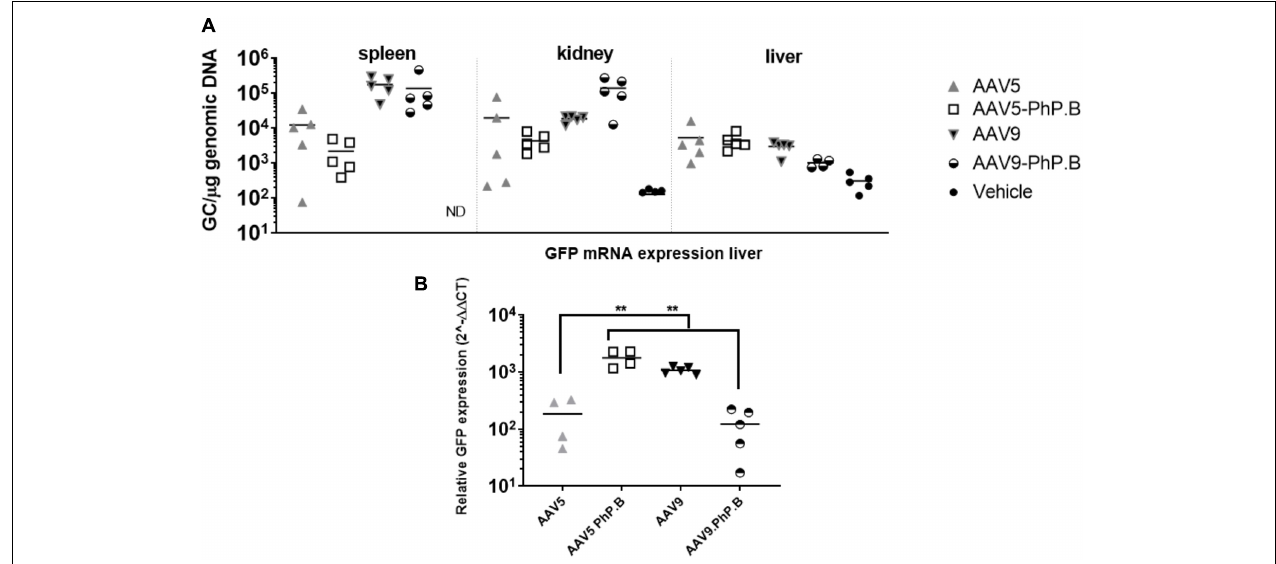
FIGURE 3 | Vector distribution in mice periphery after IV administration of AAV and liver expression. (A) Vector distribution in the spleen, kidney, and liver. (B) GFP mRNA expression in the liver with elevated levels in AAV5-PhP.B compared with AAV5. Asterisks indicate a statistical significance of p ≤